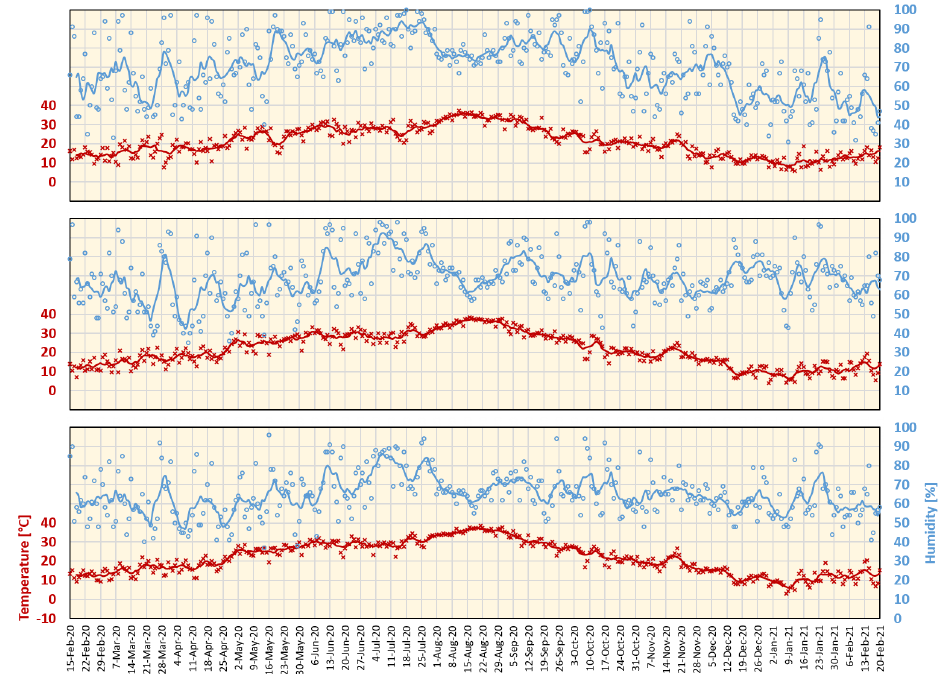
Figure 1. Daily maximum temperature and average humidity for Tokyo ( top ), Aichi (Nagoya) ( middle ), and Osaka ( bottom ) from 15 February 2020 to 20 February 2021. Lines represent a 7- day average.